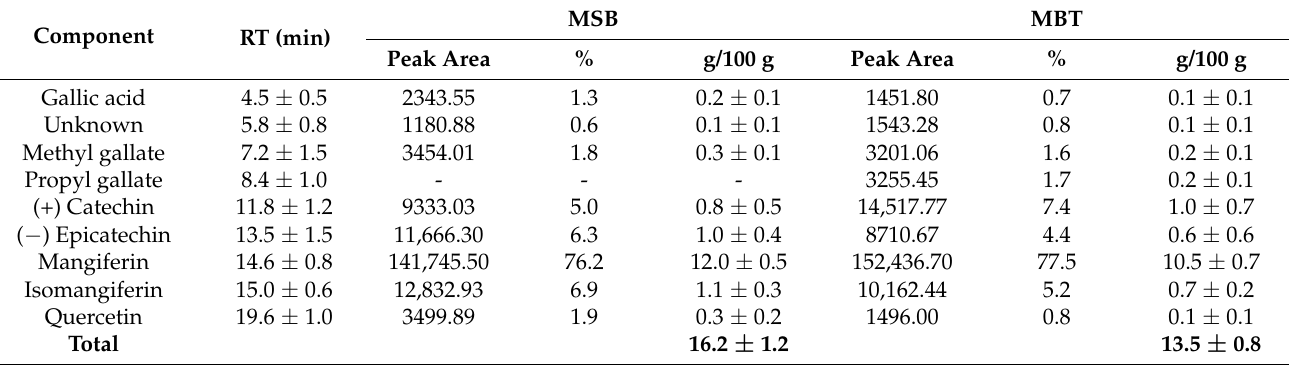
Table 9. HPLC-DAD analysis of bioactive green extracts from mango stem bark and branch tree, Haden variety. Component